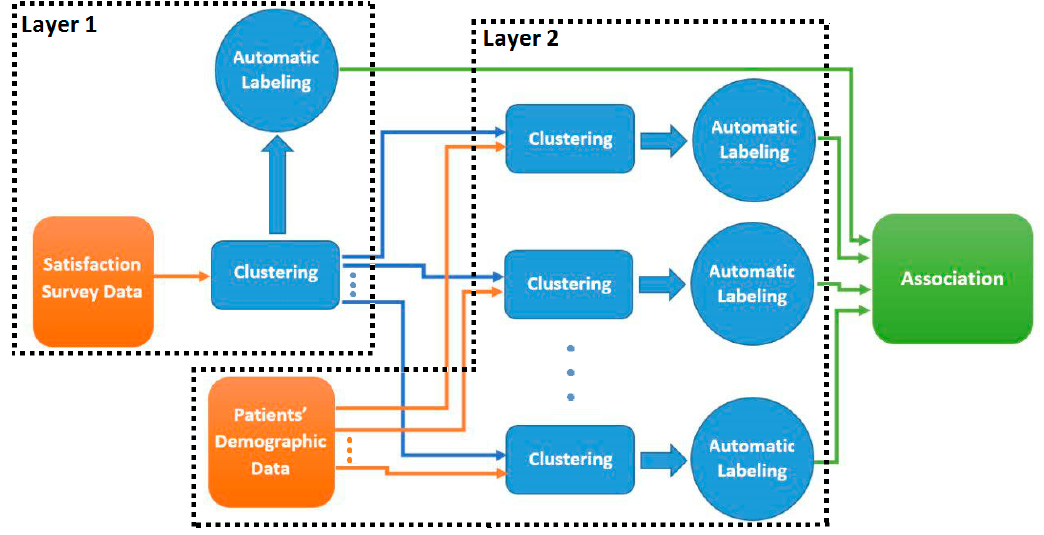
Figure 1. Two-layered analysis method. In the first layer, the clusters and their labels are generated based on the satisfaction questions. In second layer, the clusters of first layer are re-clustered based on patient demographic data.